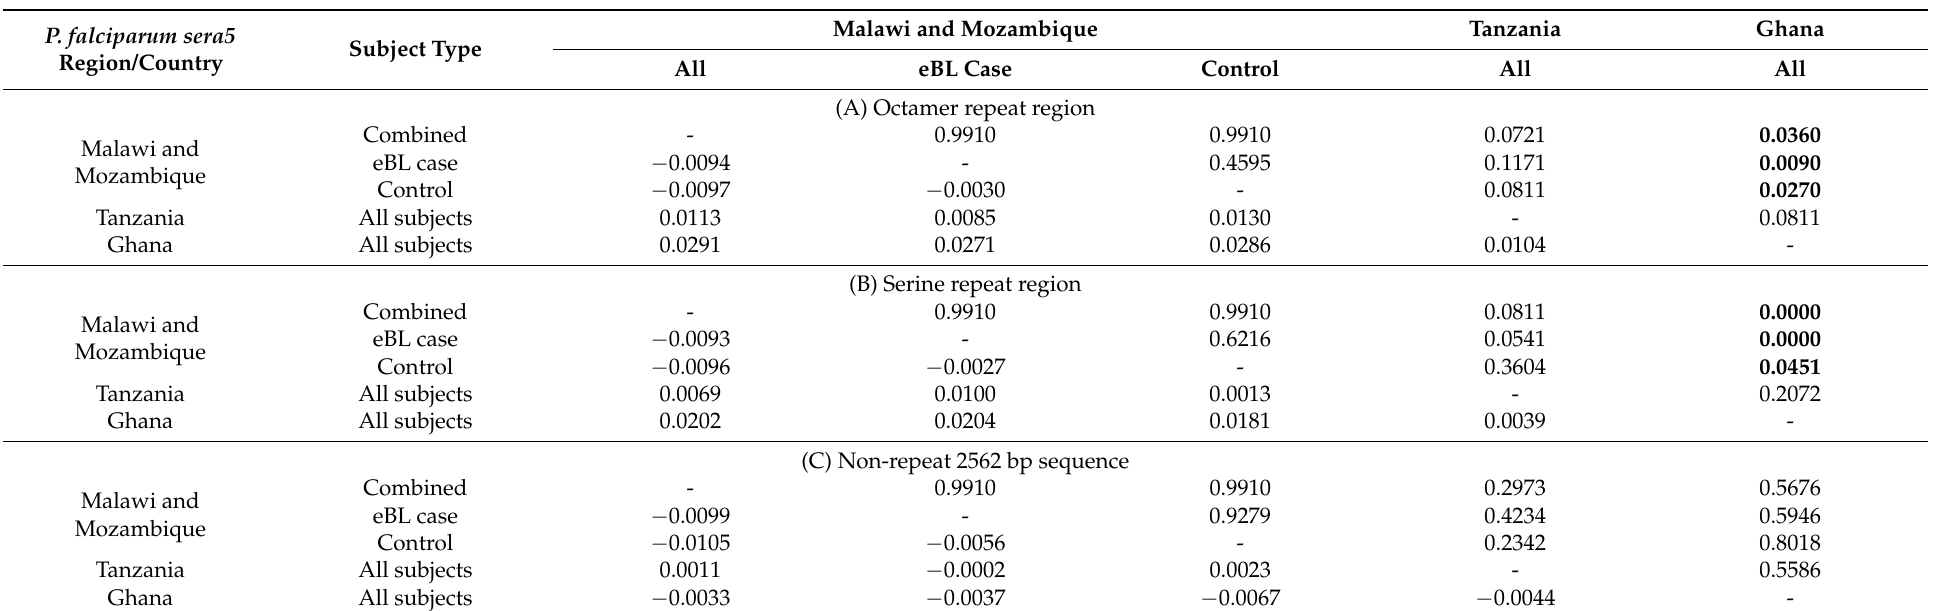
Table 5. Genetic differentiation ( Fst ) of the P. falciparum sera5